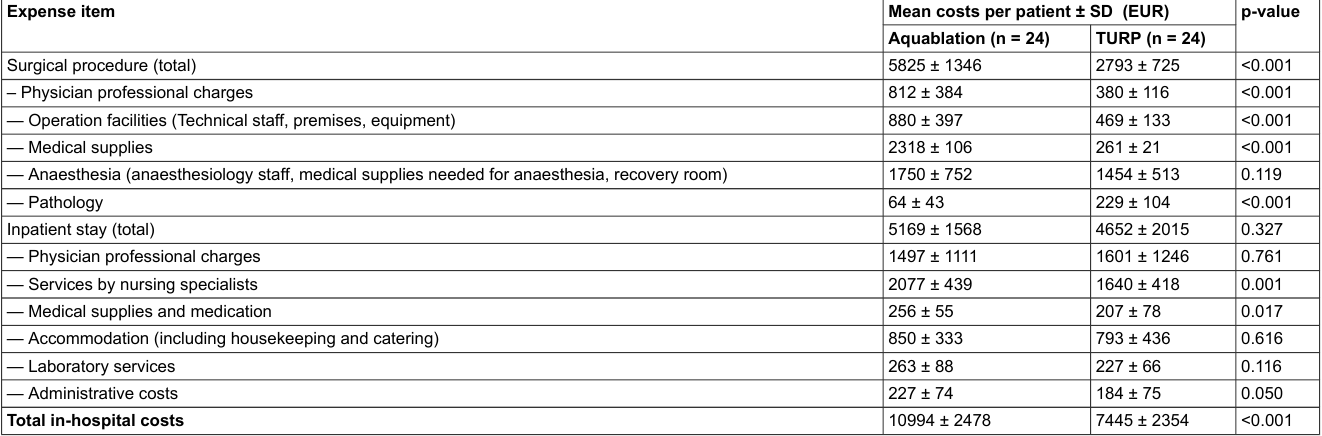
Table 2: Cost breakdown for in-hospital costs arising from aquablation and TURP. Expense item